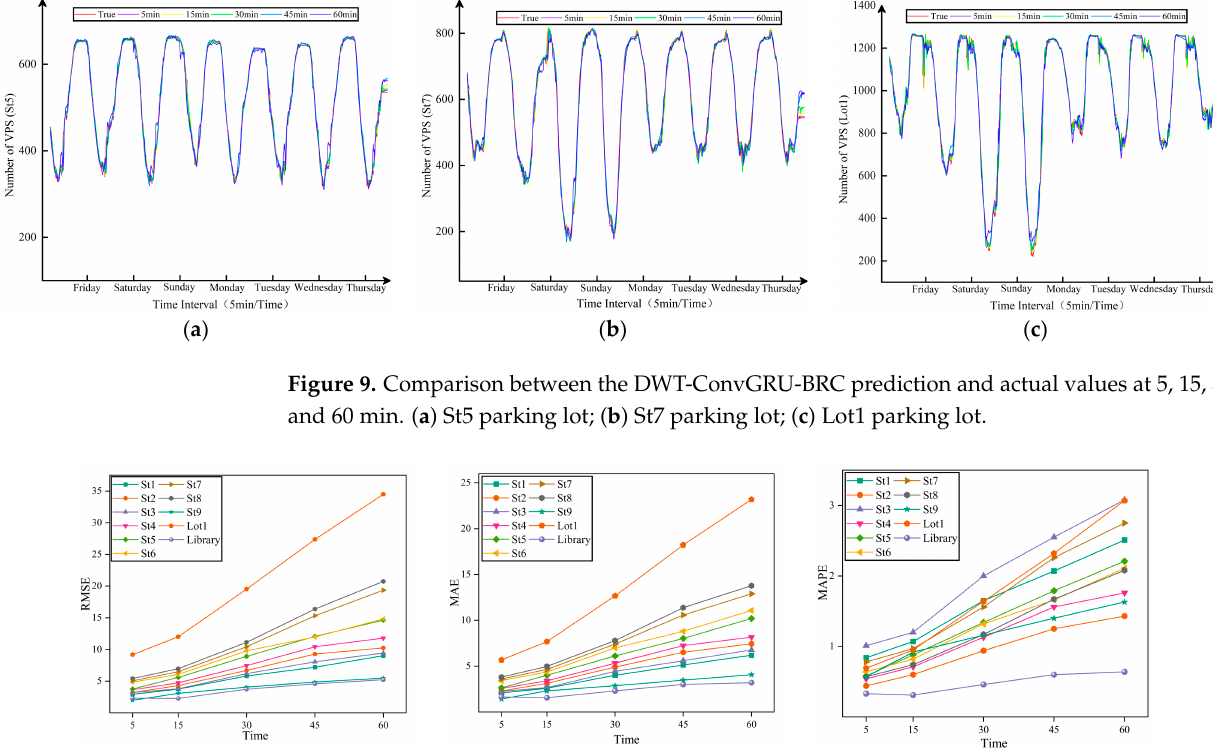
Figure 10. DWT-ConvGRU-BRC model evaluation metrics for each parking lot. ( a ) RMSE; ( b ) MAE; ( c ) MAPE.